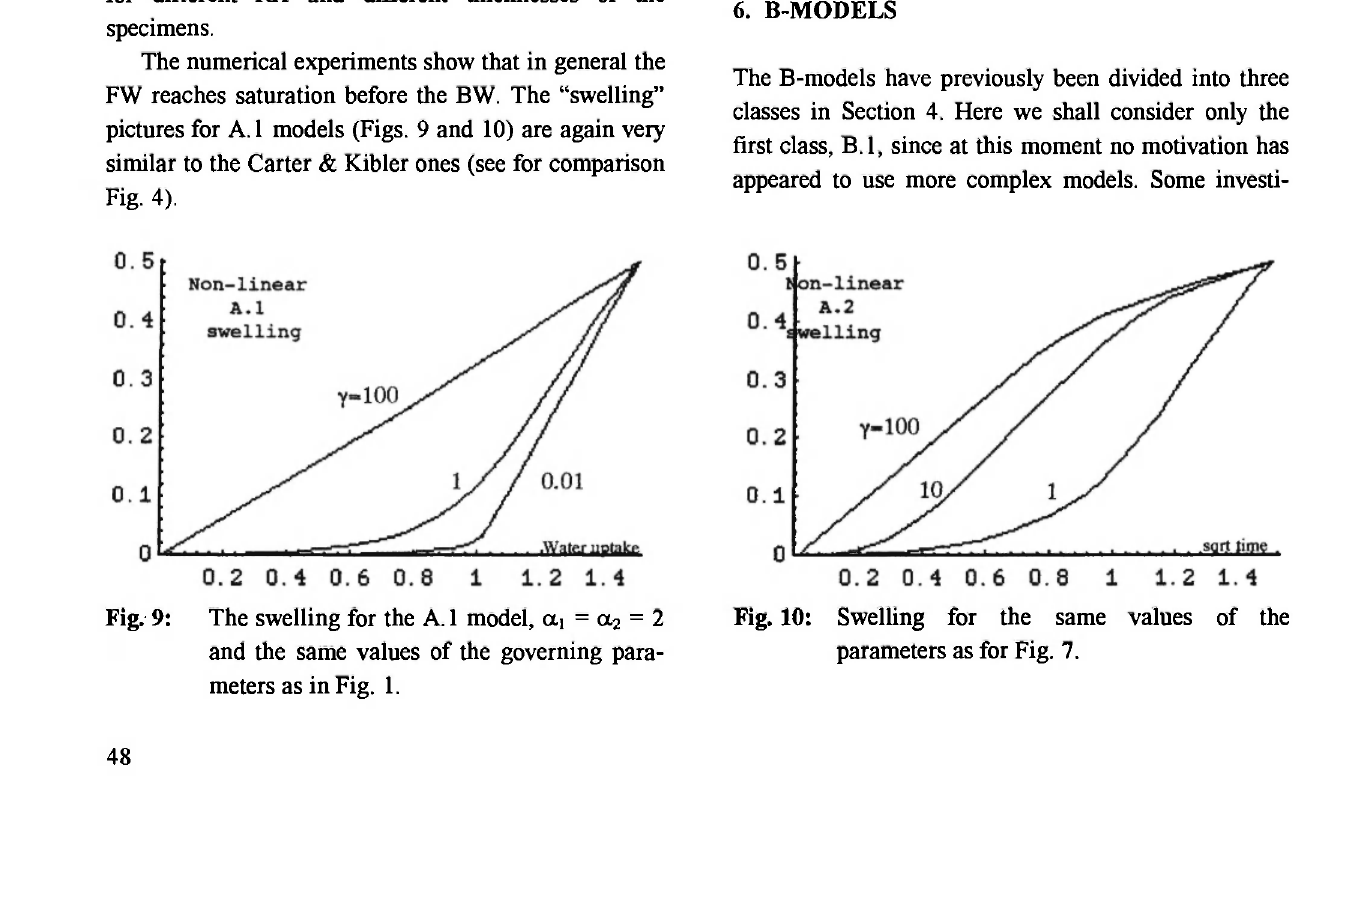
Fig. 8: The sorption for the A.l model, αϊ = α 2 = 2 and the same values of the governing parameters as in Fig. 1.